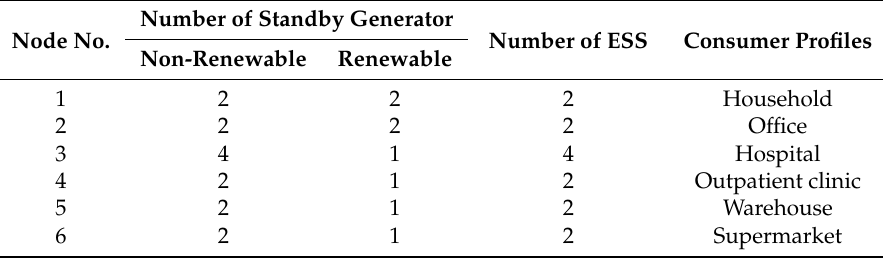
Table 1. Number of standby generator, energy storage system (ESS), types of consumer profiles and their loads included in the low voltage (LV)